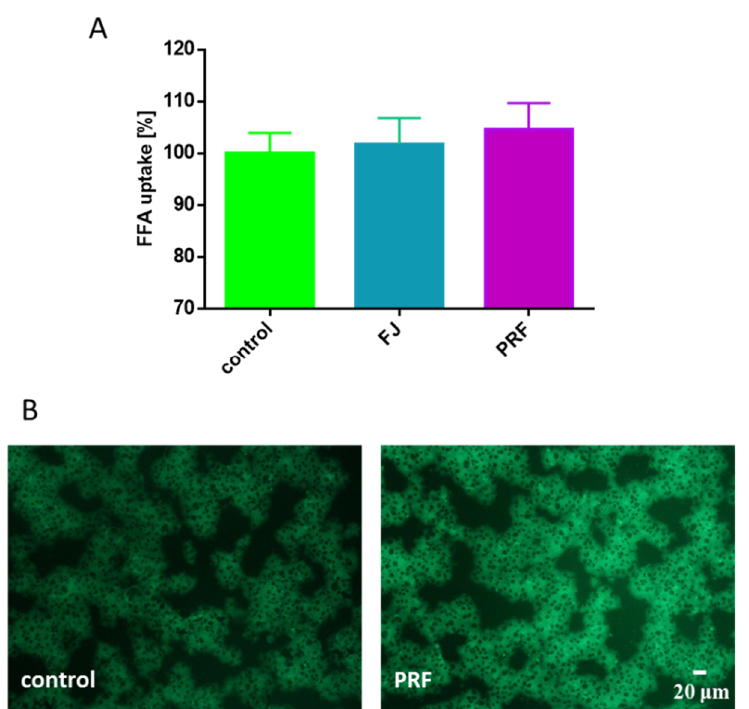
Figure 8. The influence V. opulus extracts on fatty acid analogue TF2-C12 uptake measured in MIN6 cells with an FFA uptake assay observed after treating cells with the extracts at IC 0 for 24 h ( A ); control cells were not exposed to any compound but the vehicle; values are means ± standard deviations, n ≥ 5; statistical significance was calculated versus control cells. Cells loaded with TF2-C12 visualized under fluorescent microscope (200 × magnification) ( B ).